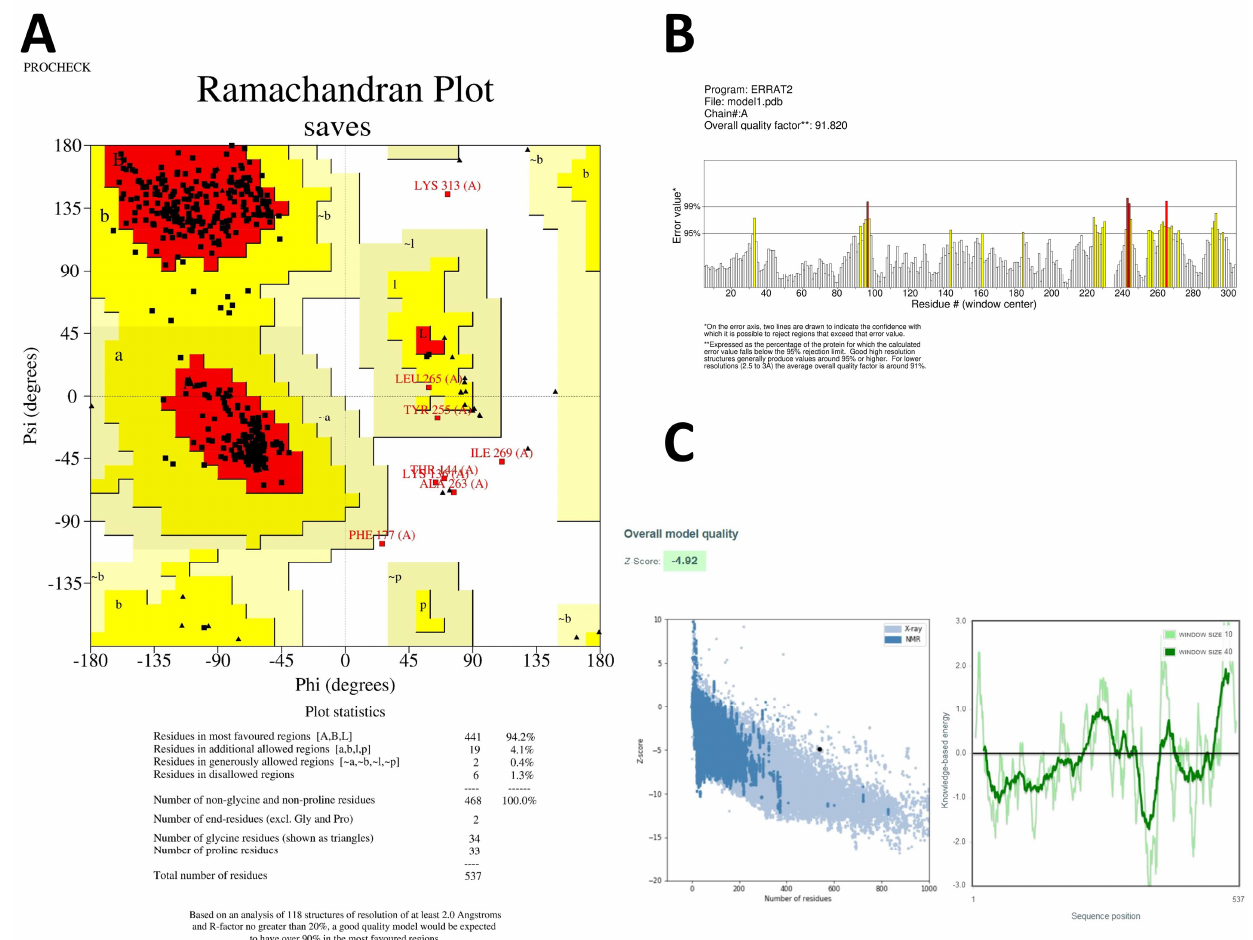
Figure 2. Validation plots and scores for the TrRosetta server’s predicted 3D structure of RmGABACls showing ( A ) the Ramachandran plot where the red, yellow and black colors represents most favorable, favorable, and disallowed region respectively, Phi and Psi bond represent the torsion angle which predict the possible conformation of the peptides. ( B ) the ERRAT’s overall quality factor value, and ( C ) the PROSA servers’ Z-score values.